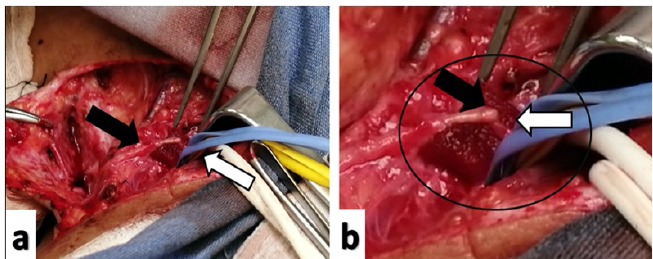
Figure 1 - -terminal anastomosis of the phrenic nerve (black arrow) and the spinal accessory nerve (white arrow). a A tensionless anastomosis. b Enlarged view of the anastomosis that is inside the circle.